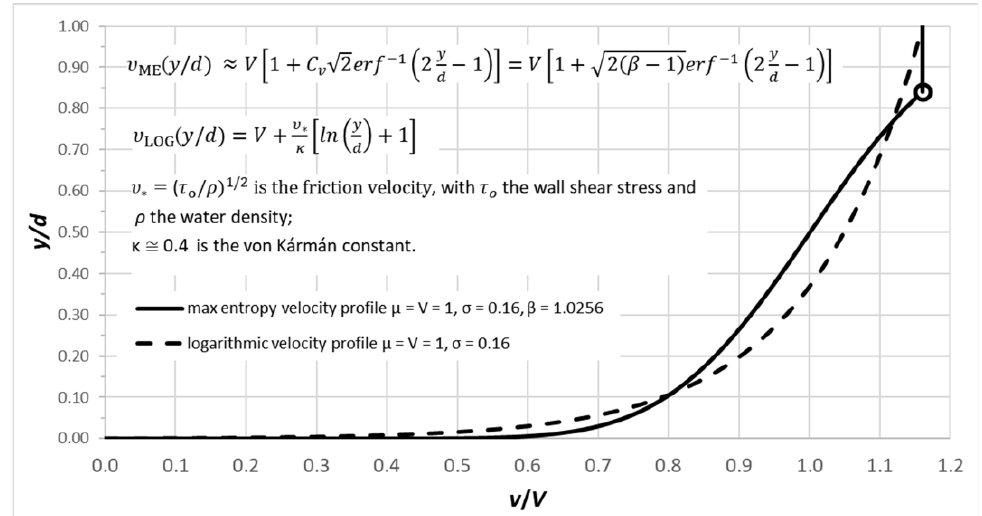
Figure 7. Comparison of maximum-entropy and logarithmic velocity profiles; β = 1.0256. It is worth noting that the surface velocity derived via the truncation at y / d = 0.841 coincides with the surface velocity of a logarithmic profile v LOG ( y / d = 1) with the same mean and standard deviation, i.e., the same C v or β . Figure 7 shows the two (normalised) profiles for V = 1 and σ = 0.16 or C v = 0.16 and β = 1.0256. The maximum-entropy